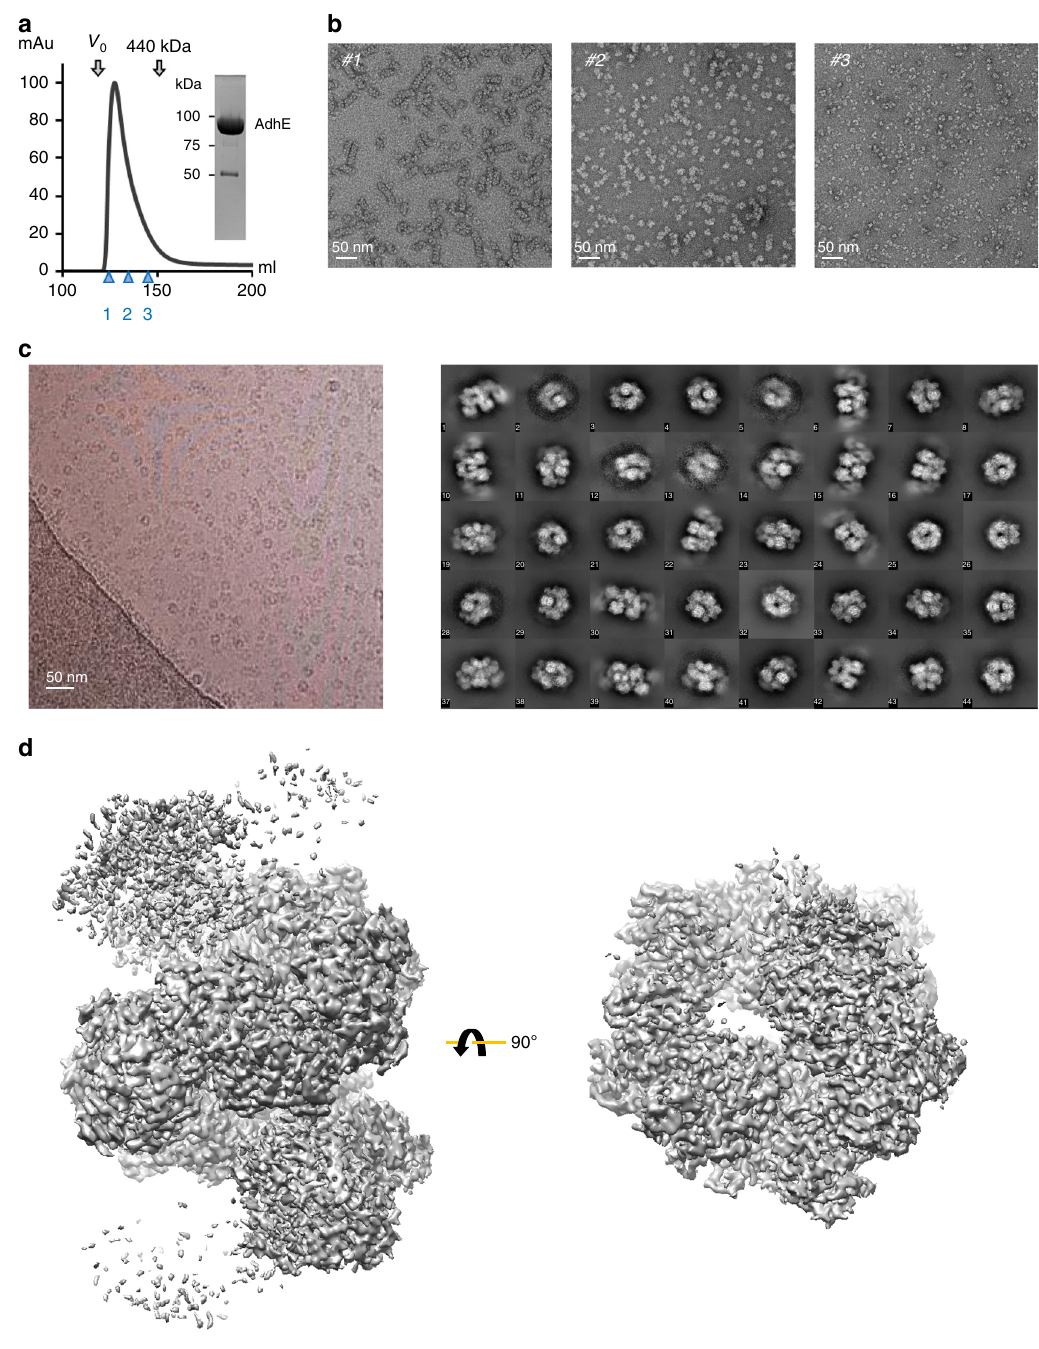
Fig. 1 Cryo-EM analysis of AdhE. a AdhE eluted across a broad molecular weight range in Superdex 200 gel- fi ltration. The void volume ( V 0 ) and elution volume for a molecular weight marker are indicated above the elution pro fi le, and the fractions examined by negative stain EM are indicated below the pro fi le. An SDS-PAGE gel shows the purity of AdhE used as input for the gel- fi ltration. b Negative stain EM analysis of fractions 1, 2 and 3 showing that AdhE forms a range of higher order structures. Scale bar 50 nm. c A representative micrograph (left) and 2D class averages (right). d Cryo-EM maps of AdhE in two different orientations. The residual density at the top and the bottom in the left panel indicates the helical property of